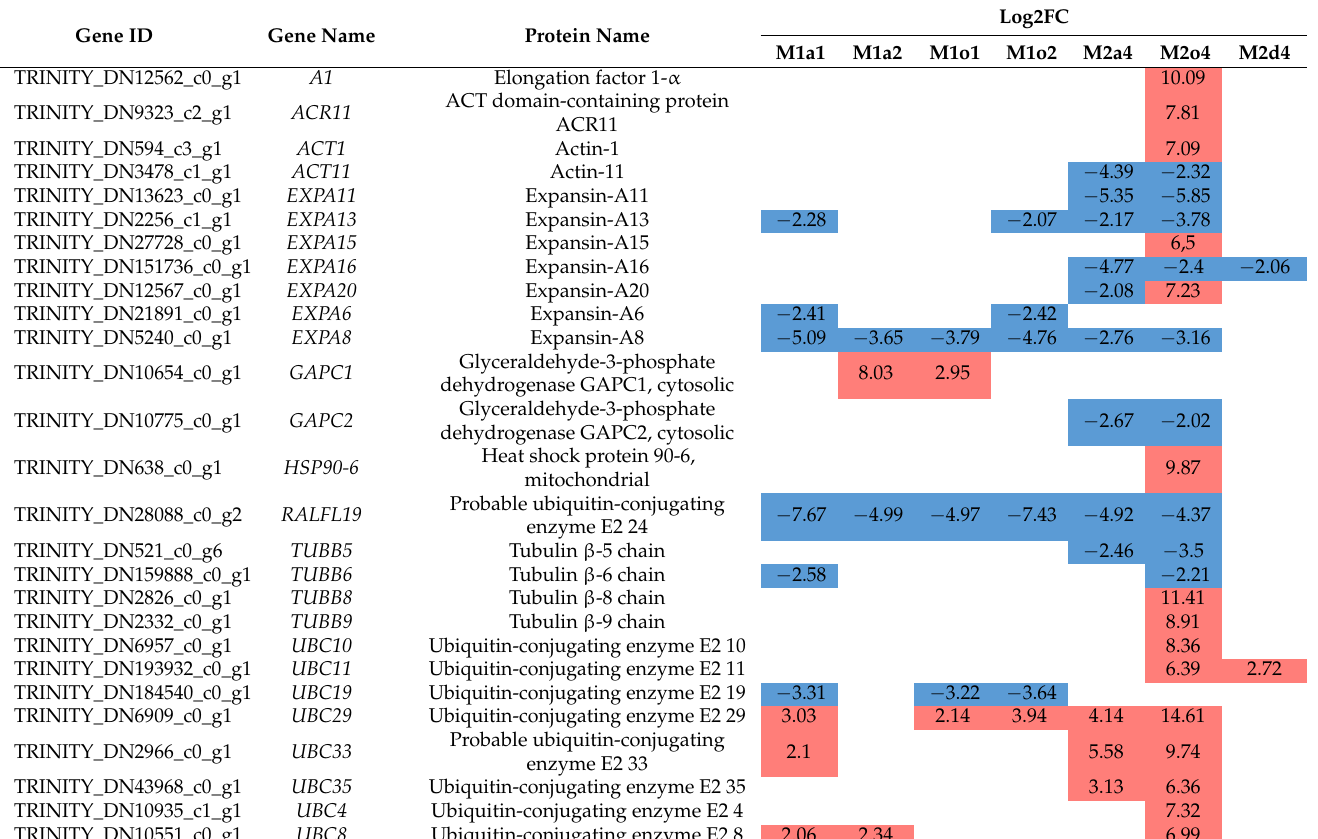
Table 3. List of common housekeeping genes in A. thaliana (gene name) that were differen- tially expressed (DEGs) in the ovules of apomictic L. multiflorum (M) in S1 and S2, and sex- ual L. auriculifolium (a) and L. ovalifolium (o) in S1, S2, and S3/S4. DEGs were filtered by |log2 fold-change (log2FC)| >2 (red: up-regulated DEGs; blue: down-regulated